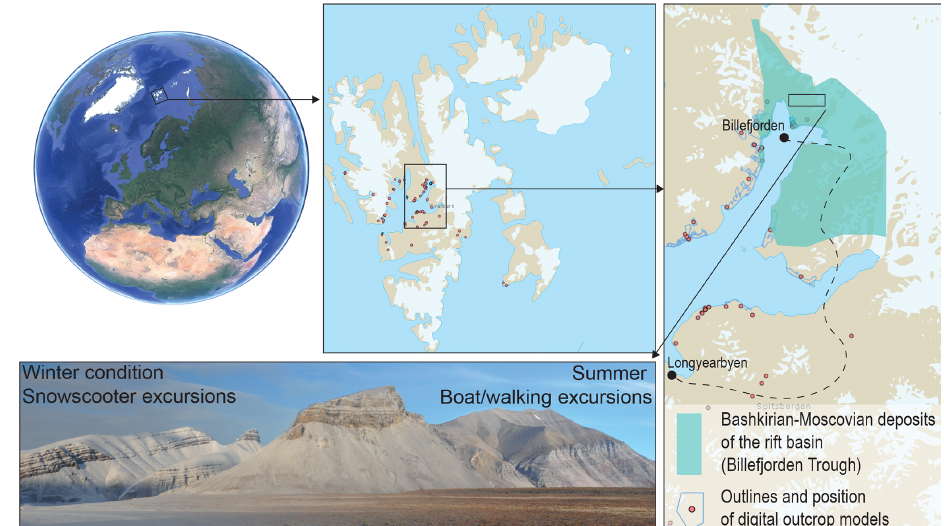
Figure 3. Location of Svalbard and the Billefjorden Trough, which is the main field area for the AG222 course. Winter and summer conditions of the same mountain, Løvehovden (see https://toposvalbard.npolar.no/, last access: 7 September 2021, for exact location), are shown for comparison.